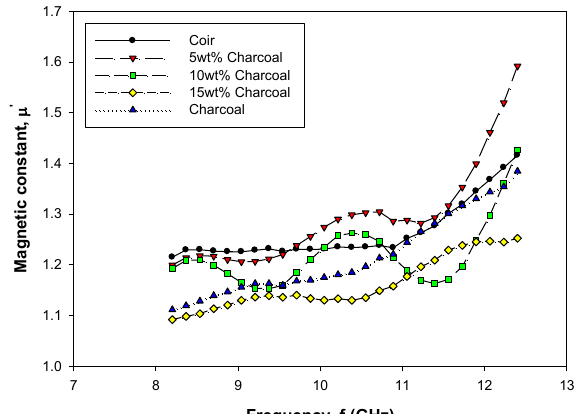
Figure 5 : Magnetic constant of 5 different samples